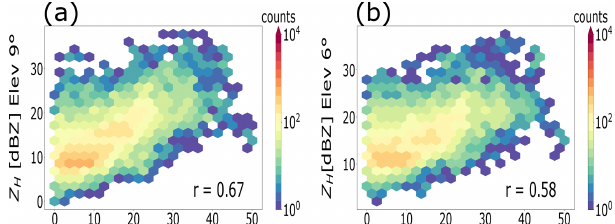
Figure 7. As in Fig. 6 but for a collection of convective events. Counts indicate the number of points in the